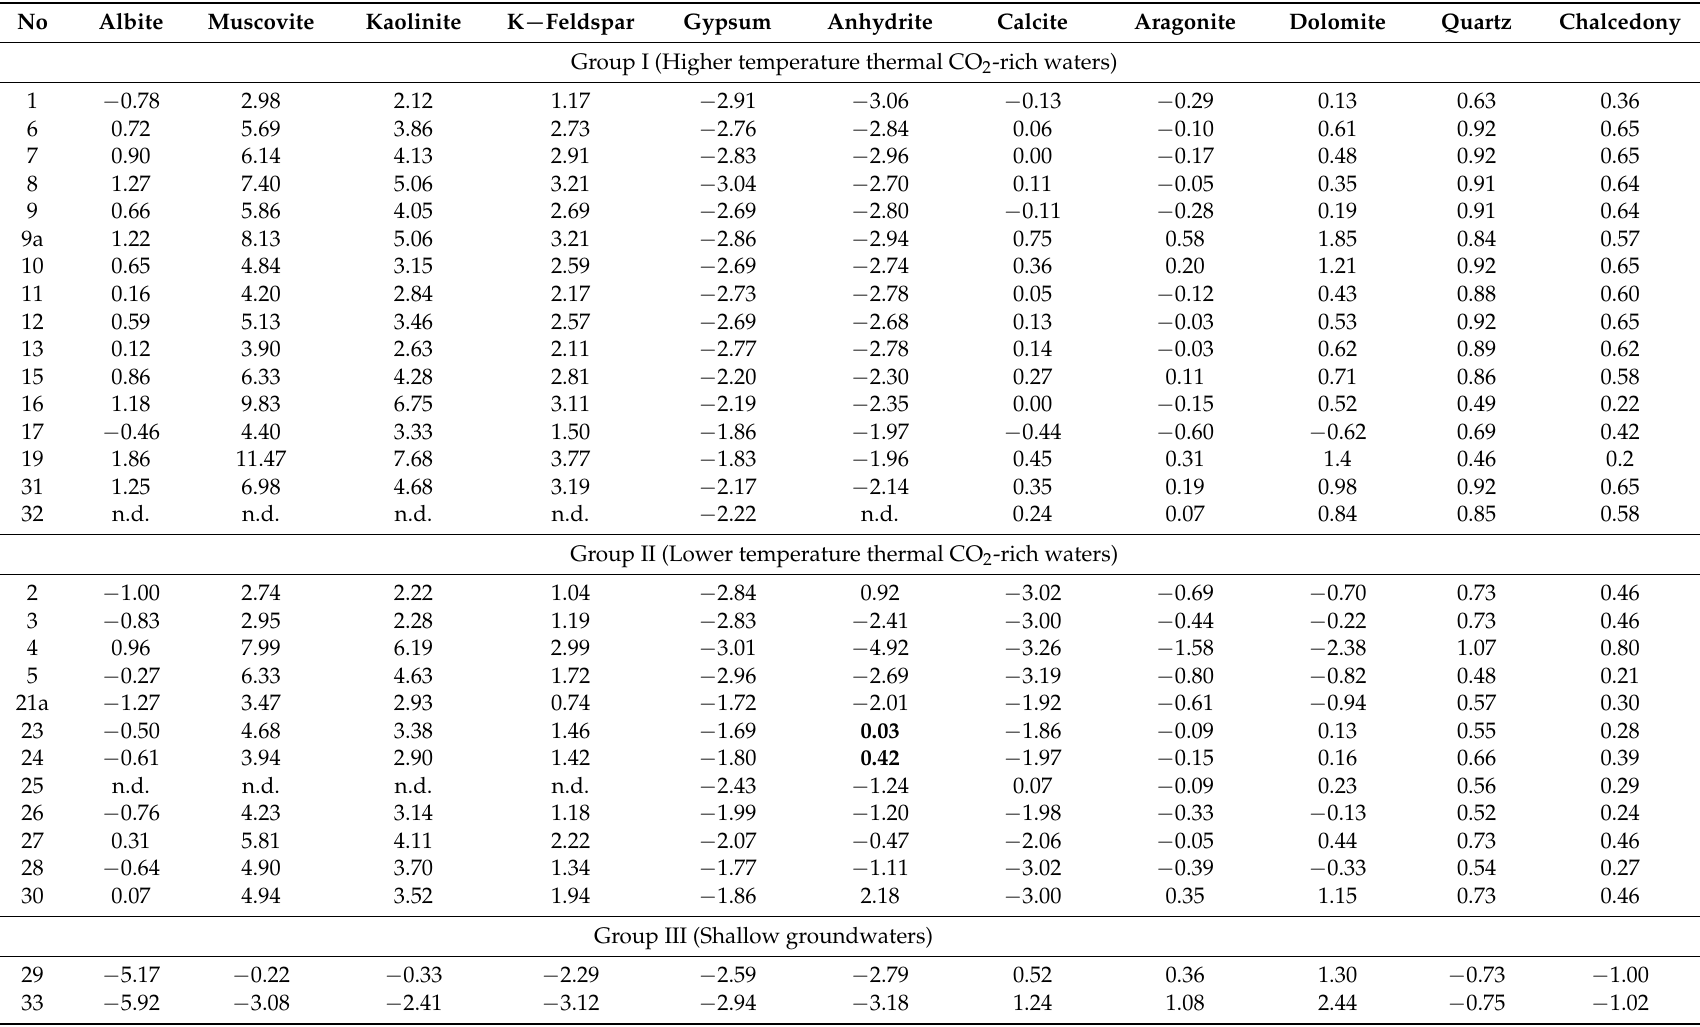
Table 3. Saturation indices, calculated at the measured discharge temperature, of selected